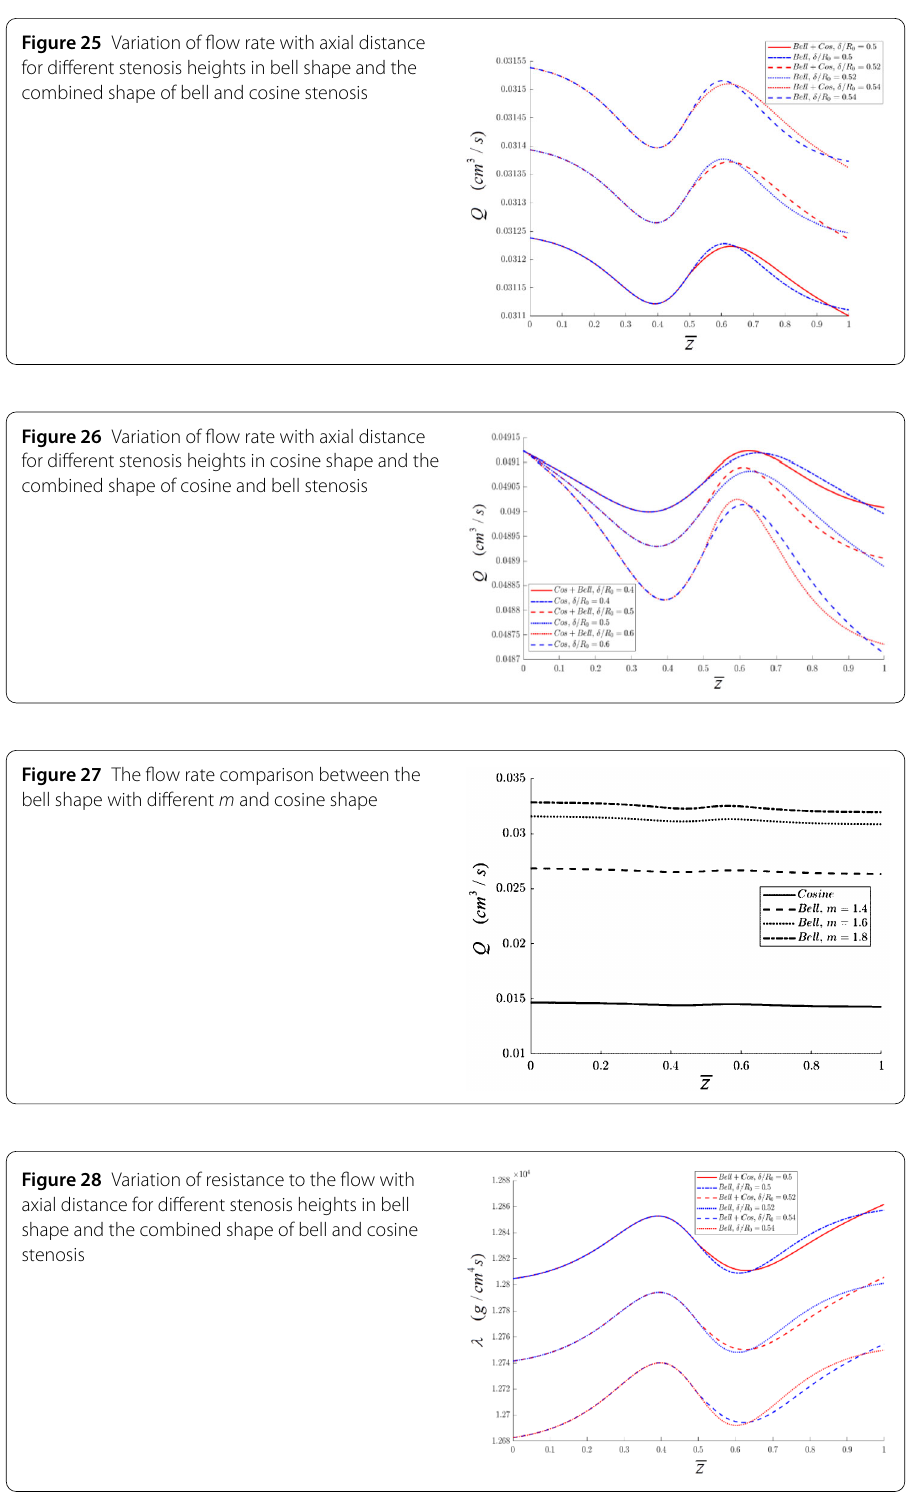
Figure 25 Variation of flow rate with axial distance for different stenosis heights in bell shape and the combined shape of bell and cosine stenosis